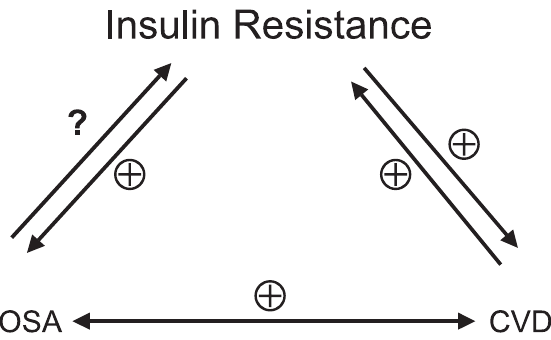
Figure 1 - Scheme illustrating the actual hypothesis of possible bidirectional relationships between obstructive sleep apneas (OSA), insulin resistance, and cardiovascular (CVD)